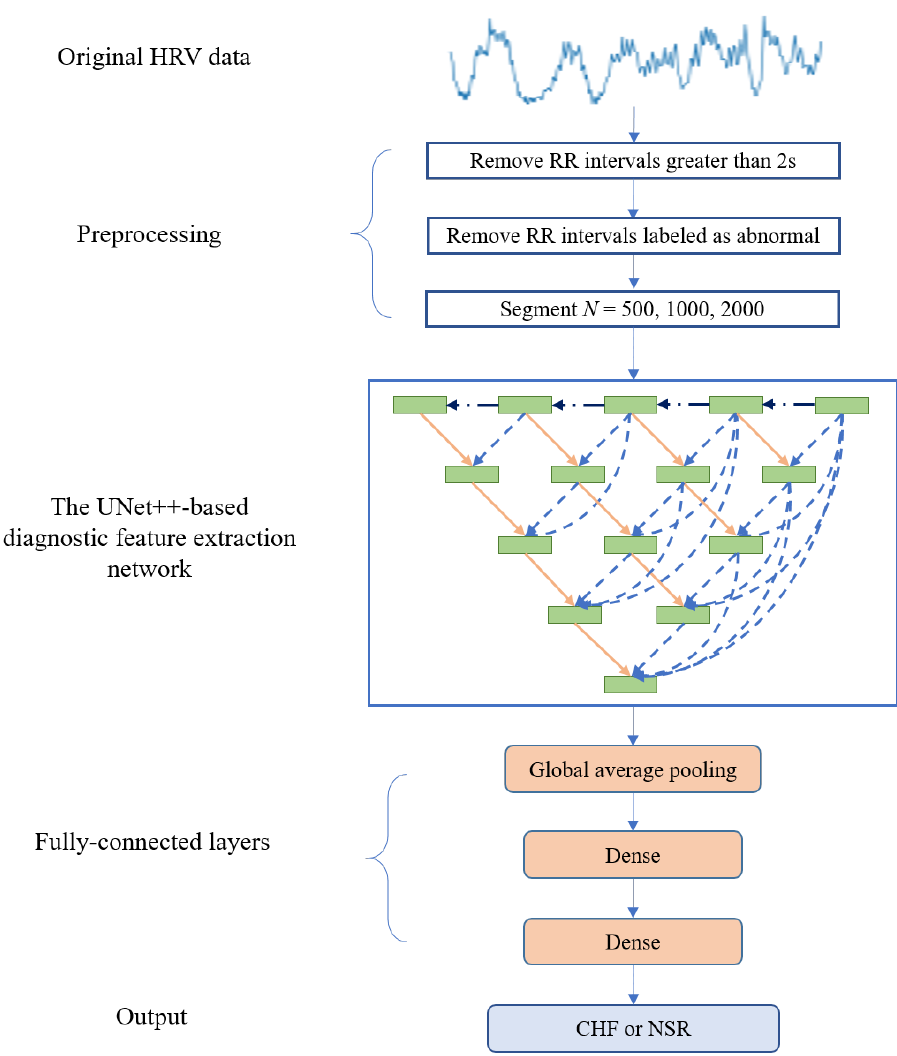
Figure 1. An overview of the method used in this